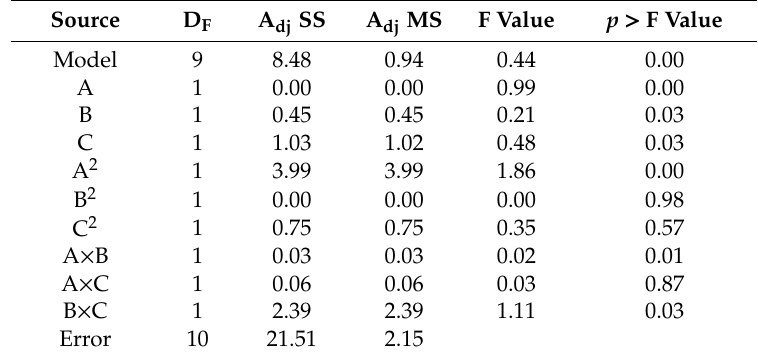
Table 3. Analysis of variance (ANOVA) for the photodegradation of DNP on PAN-g-Alg@Ag NC. Source D F A dj SS A dj MS F Value p > F